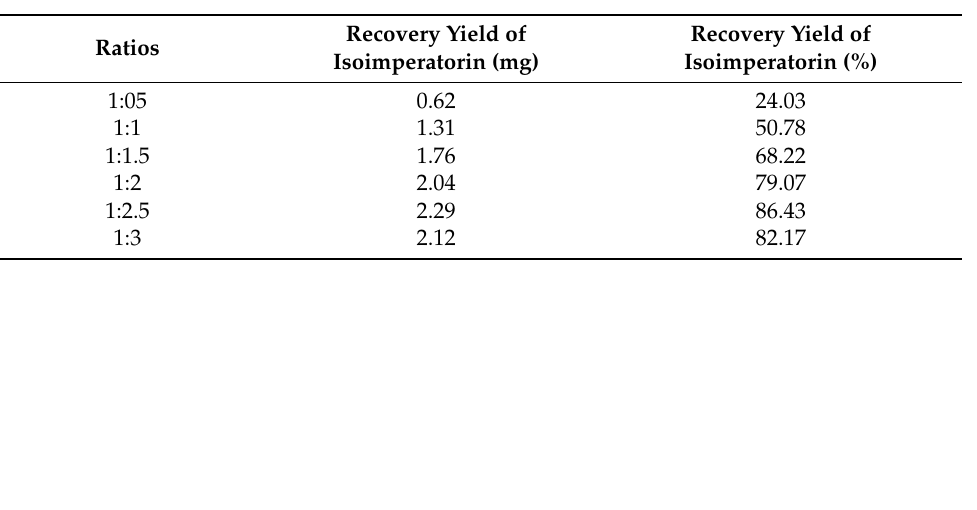
Table 3. Recovery rates of isoimperatorin at different ratios of the [Bmim][BF 4 ] IL extraction solution to DW.